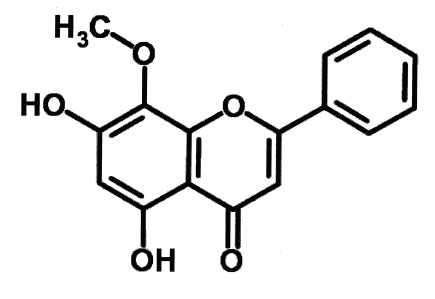
Figure 1. Structural formula of the flavonoid